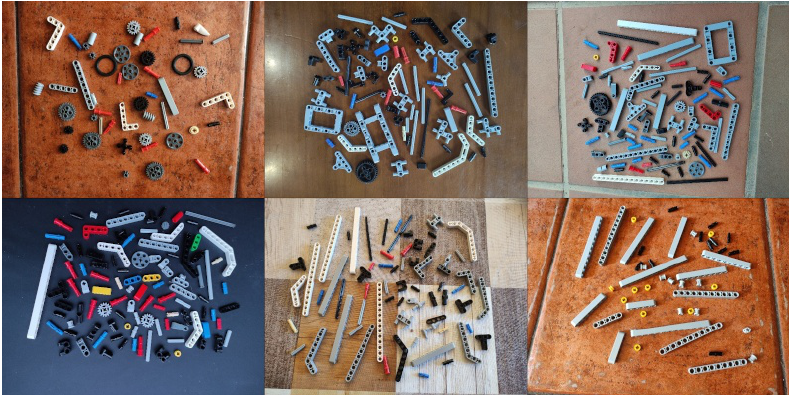
Figure 6. Uncontrolled dataset with real images and different backgrounds with different camera positions and illuminations.